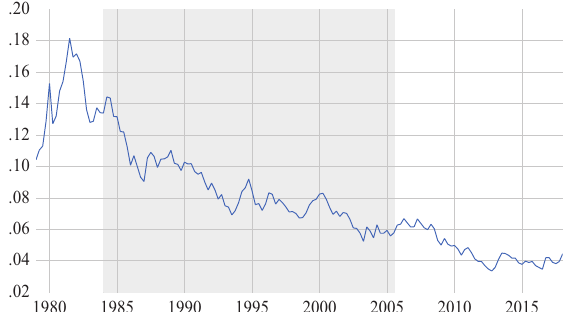
Figure 5. The time series chart of mortgage interest rates